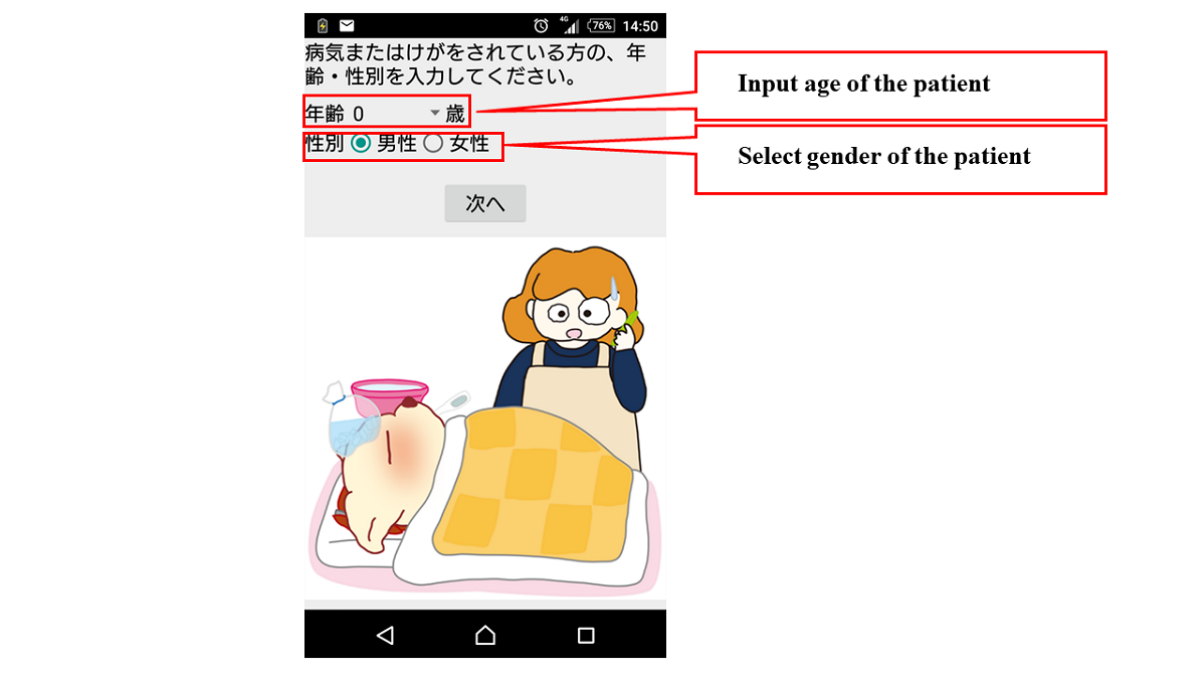
Figure 2. Screenshot of patient input about age and sex.